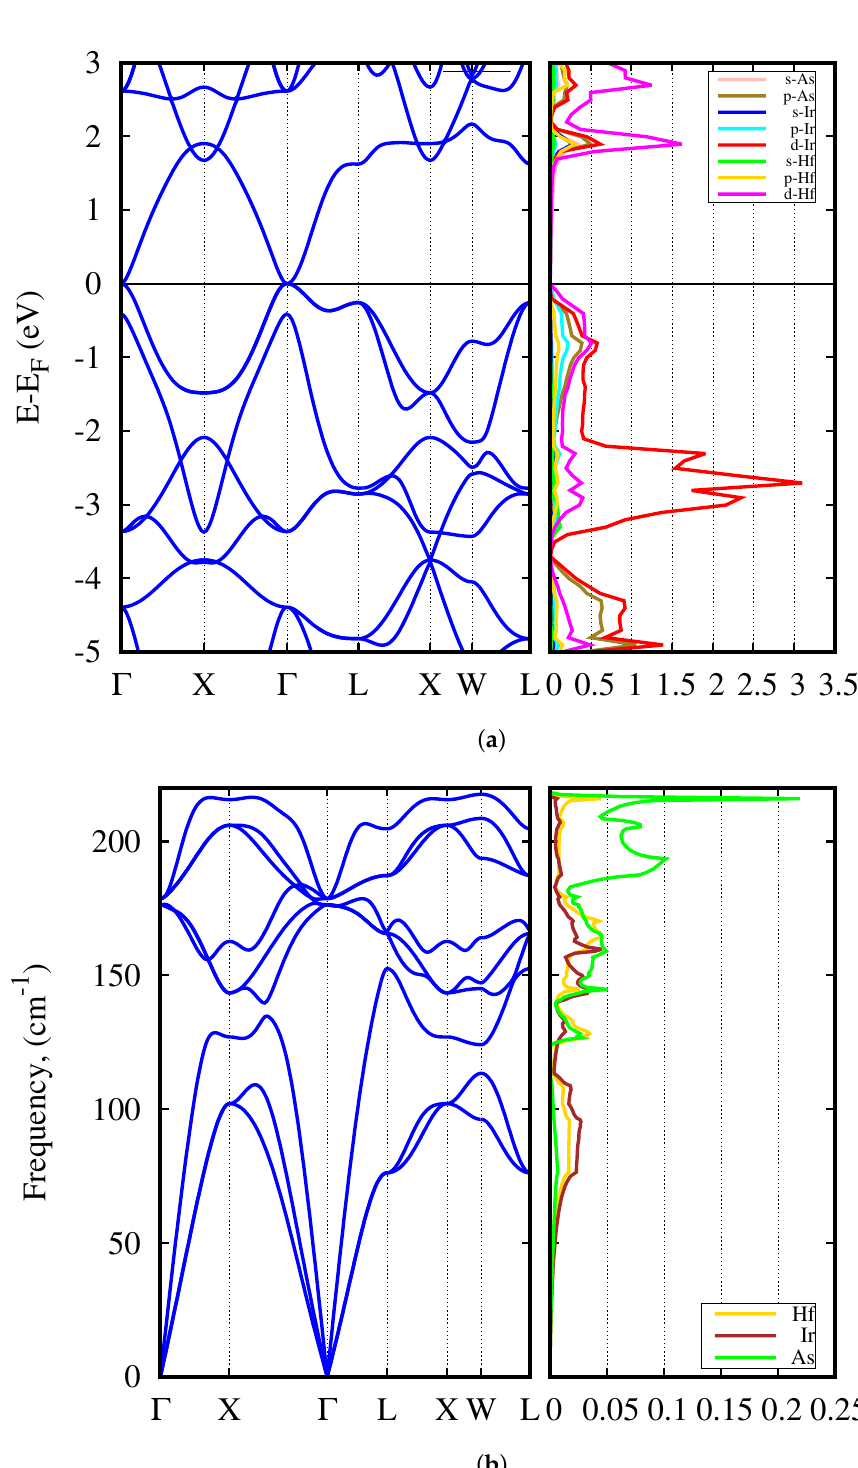
Figure 2. ( a ) Electronic band structure and corresponding partial density of state, and ( b ) phonon band structure and projected phonon density of state for HfIrAs half-Heusler